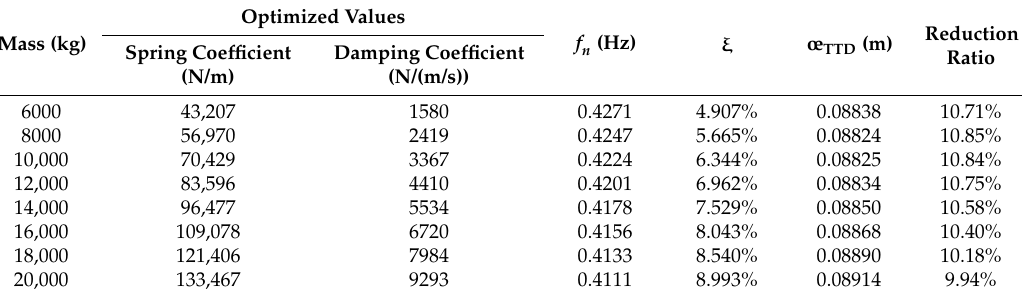
Table 5. Optimized results by genetic algorithm.